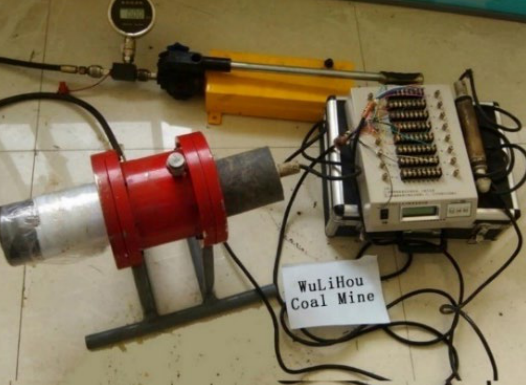
Figure 4. Test of the stress-relief method.